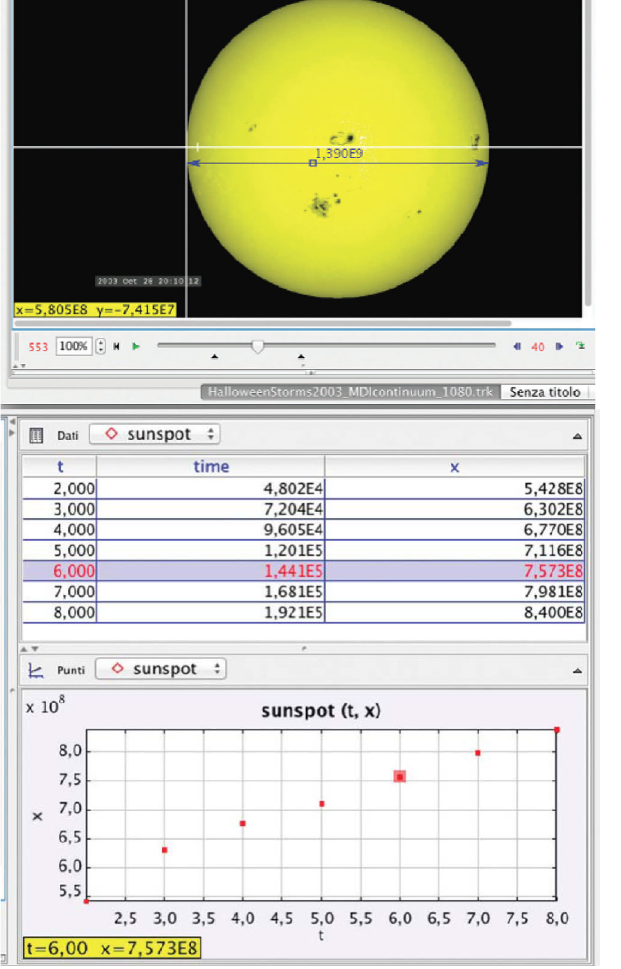
TABLE IV. Sample 2 students ’ distribution across LP1